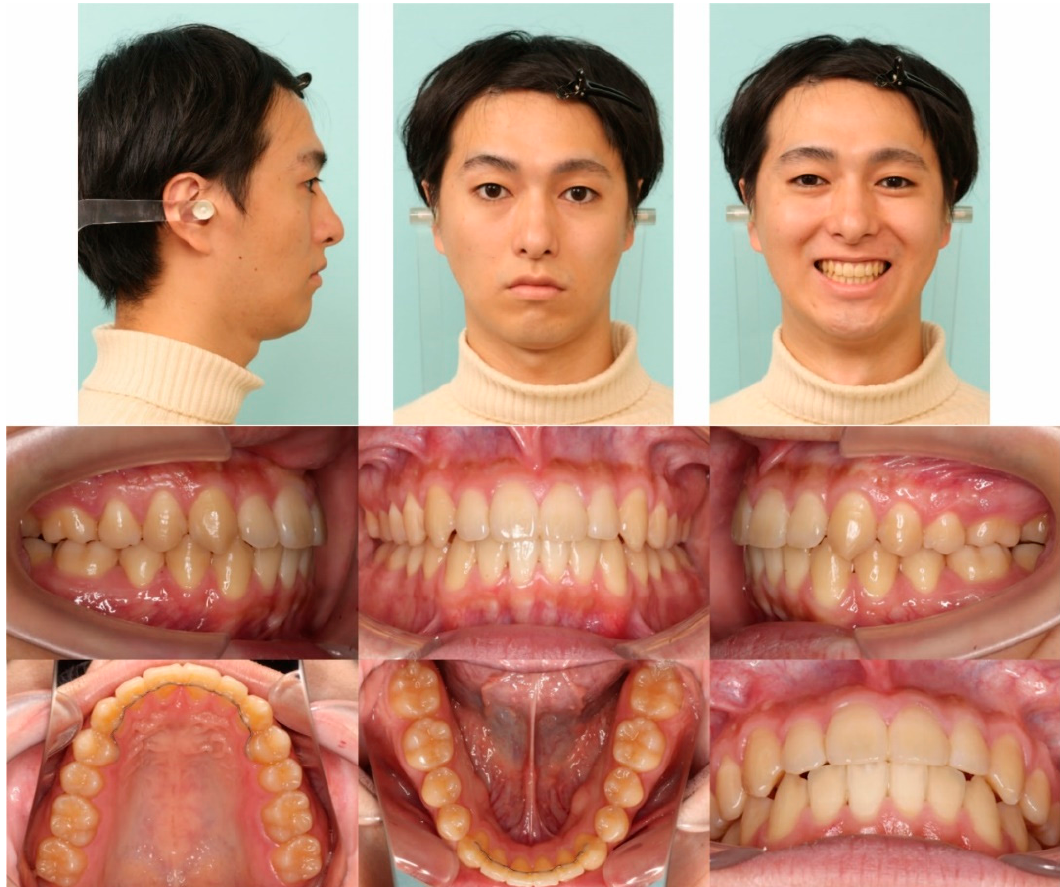
Figure 10. Facial and intraoral photographs after 2 years of retention.